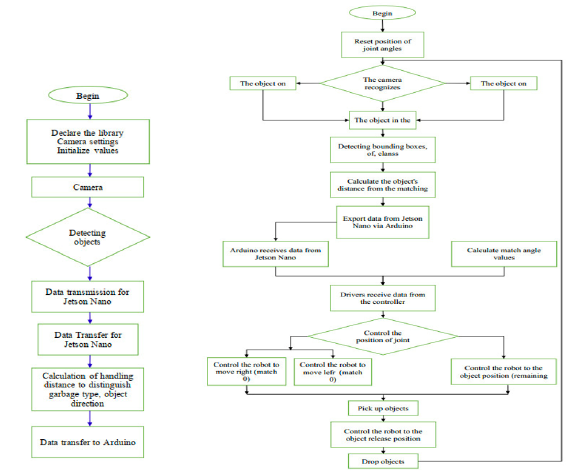
Fig. 9. Flowchart of the waste classification control algorithm of AI robot with 6 degrees of